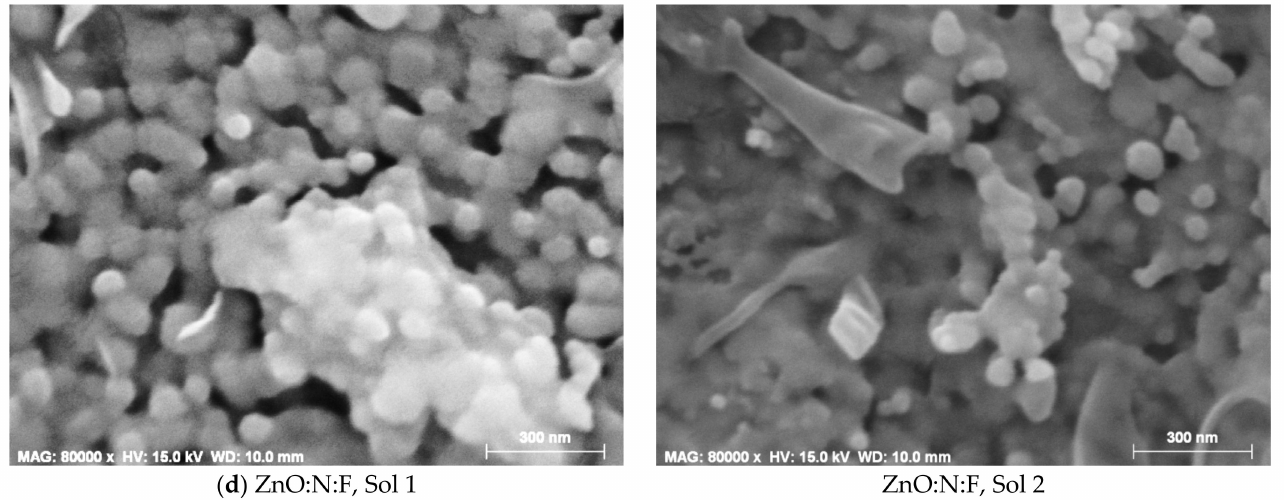
Figure 11. FESEM micrographs of ( a ) ZnO:N:F, sol 1 and ZnO:N:F sol 2 films at magnification 1000, ( b ) ZnO:N:F, sol 1 and ZnO:N:F sol 2 at magnification 20,000, ( c ) ZnO:N:F, sol 1 and ZnO:N:F sol 2 at magnification 40,000 and ( d ) ZnO:N:F, sol 1 and ZnO:N:F sol 2 at magnification 80,000. The N, F co-doped ZnO films are annealed at 600 ◦